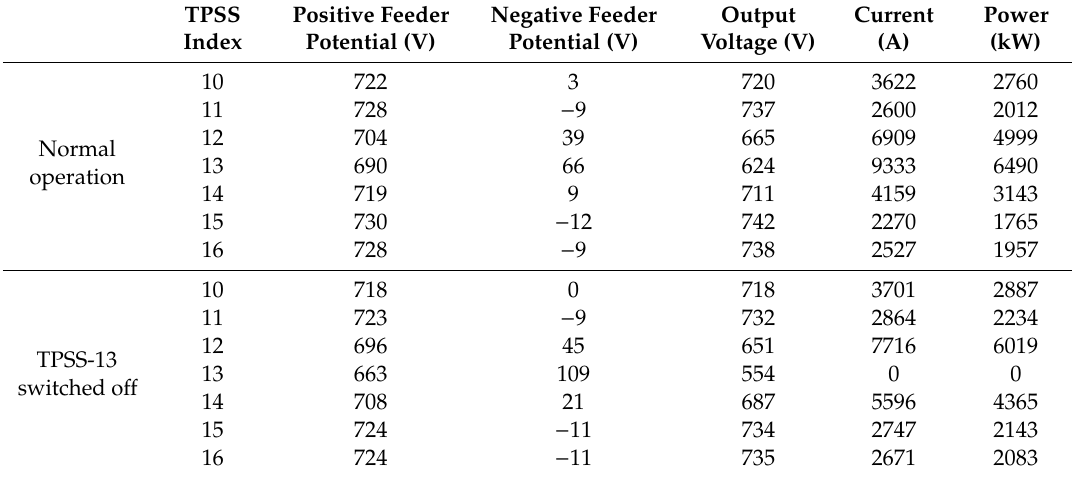
Table 5. Traction power substation (TPSS) result